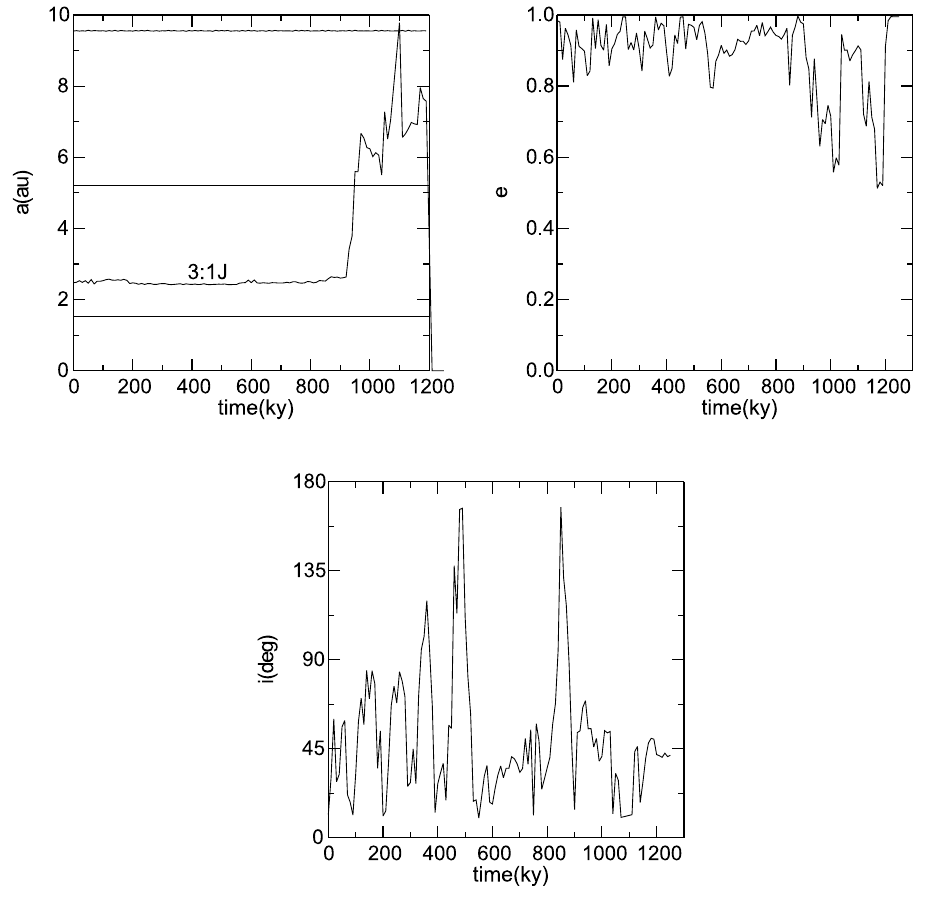
Figure 3: Forward orbital evolution of the clone no. 38 of comet 322P without NG e ff